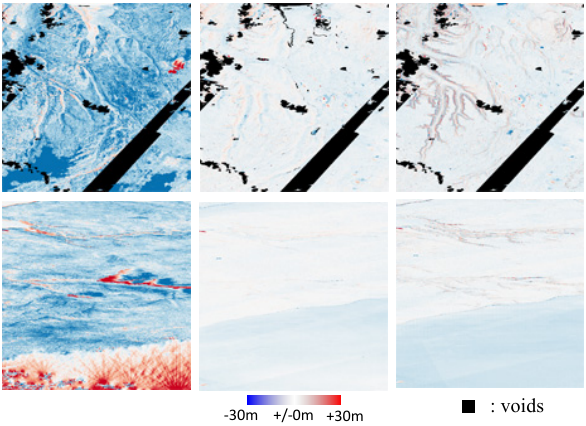
Figure 4. Height differences from AW3D30. Top: N65W018, Bottom: N78W069, Left to right: ASTER